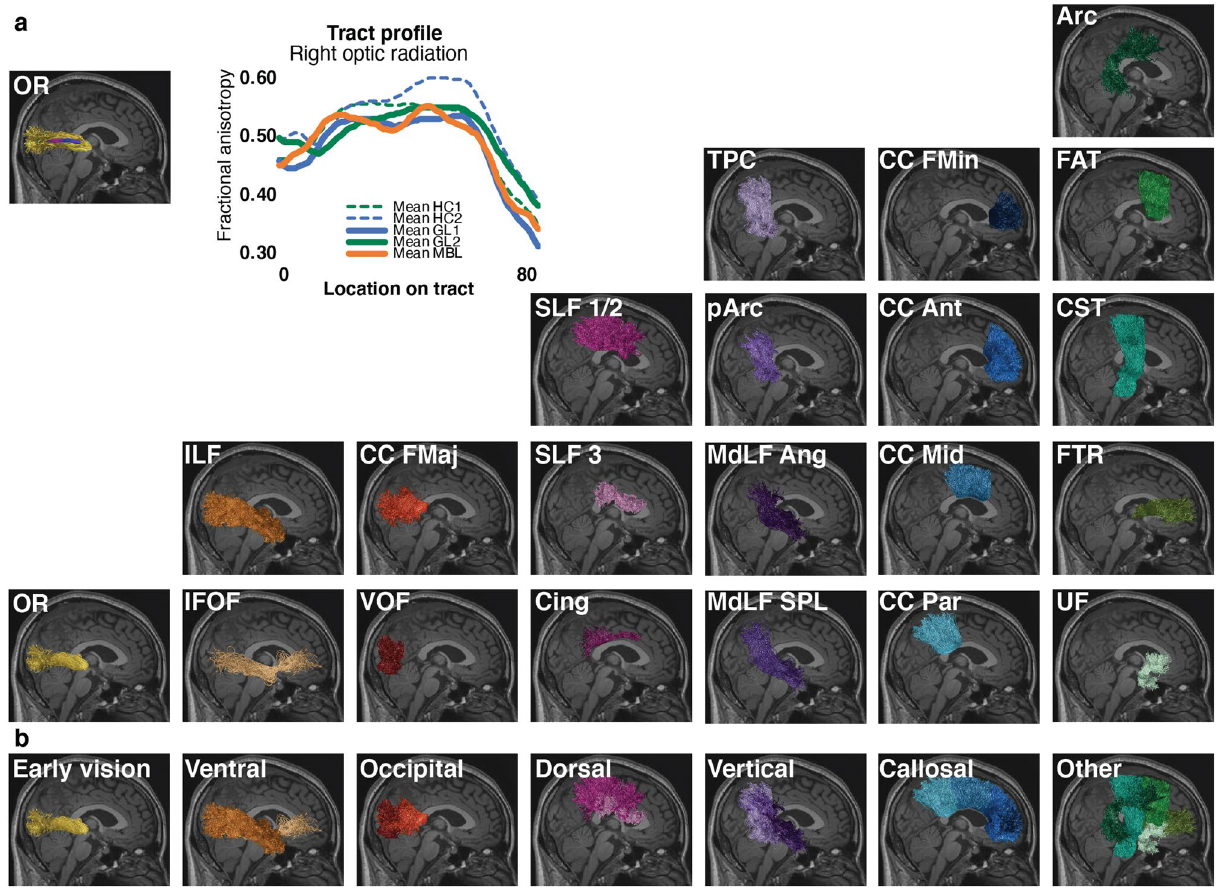
Figure 1. White matter anatomy segmentation. ( a ) Upper-left side . One representative subject white matter tract (the optic radiation) with overlayed microstructural estimate and representative optic radiation average tract profile for each participant group. Tract profiles were estimated using brainlife.io (brainlife.app.361; 41 ). Bottom-right side . The 37 WM tracts identified using the brainlife.io white matter segmentation (brainlife. app.188). ( b ) White matter tract categories. Tracts were subdivided into 7 categories. These categories were defined by the degree of involvement in vision. Only WM tracts from the right hemisphere are visualized here for a representative